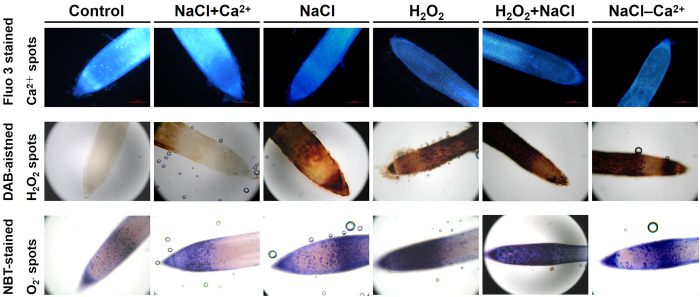
Histochemical analysis for the generation of Ca2+, H2O2 and O2− in perennial ryegrass roots.